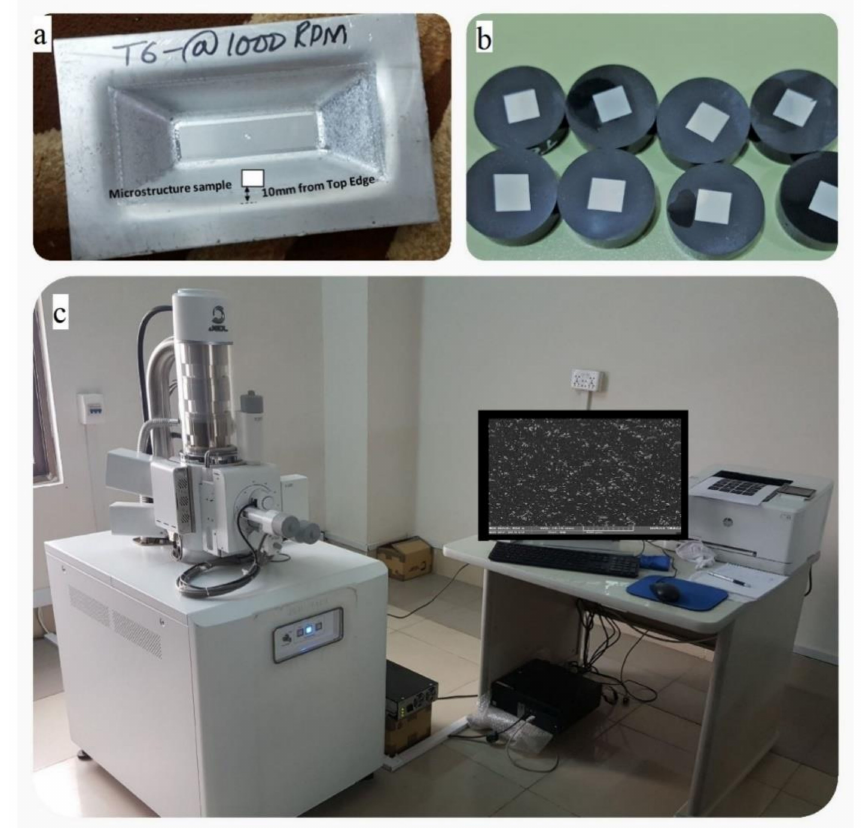
Figure 3. Metallography details: ( a ) sample extraction, ( b ) molded metallography samples and ( c ) scanning electron microscope (Model: IT100LA, JEOL Ltd. Tokyo,